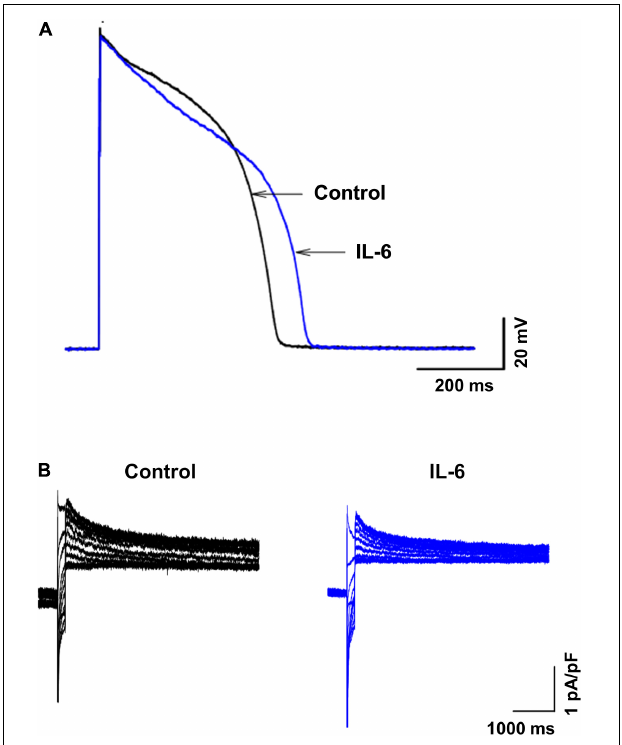
FIGURE 4 | Effects of IL-6 on action potential and I Kr in guinea pig ventricular myocytes. Representative action potentials (A) and I Kr (B) recorded from a separate set of control myocytes (black traces) and from another set of myocytes preincubated with IL-6 (200 µ g/L) for 40 min (blue traces). In panel (A) , action potentials were recorded in ventricular myocytes ( n = 18) without IL-6 (black traces, control) and in ventricular myocytes ( n = 11) preincubated with IL-6 (200 µ g/L) for 40 min (blue traces) using the current-clamp mode. In panel (B) , I Kr tail currents were recorded in ventricular myocytes ( n = 10) without IL-6 (black traces) and in ventricular myocytes ( n = 9) preincubated with IL-6 (200 µ g/L) for 40 min (blue traces) using voltage-clamp mode.